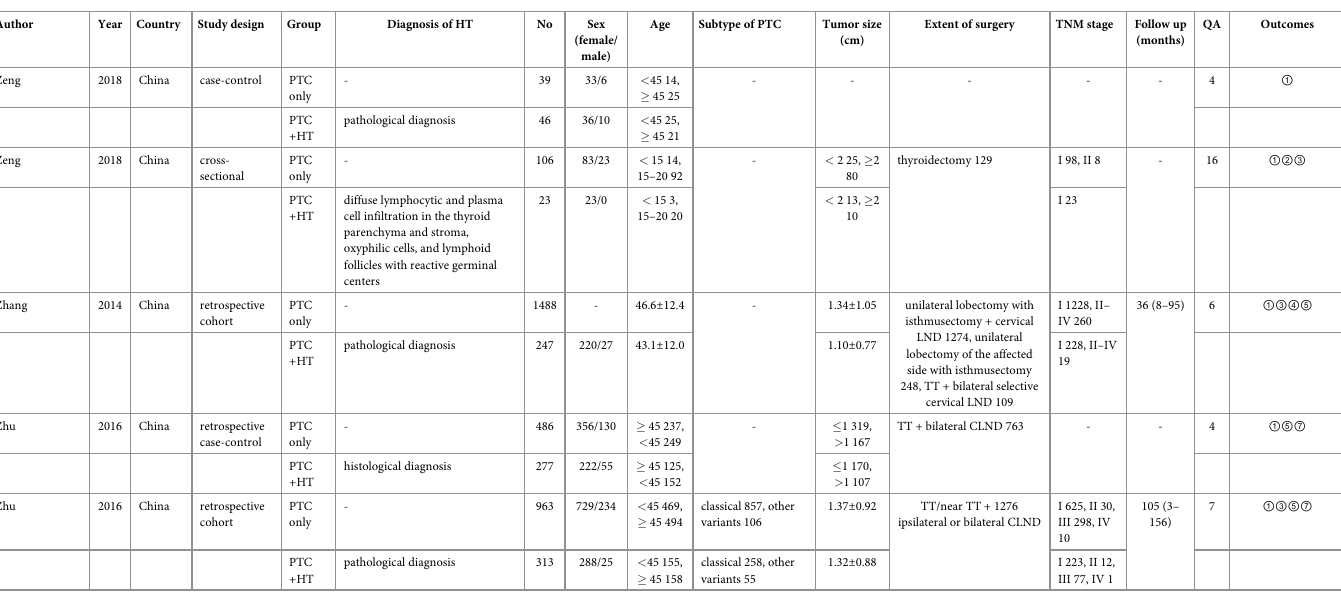
Invasion Vascular invasion. Totally 17 studies embodying 1837 patients probed into the vascular invasion. The result demonstrated that PTC patients with HT had a lower risk of vascular inva- sion than those without (OR: 0.718, 95%CI: 0.572–0.901, P = 0.004) (Table 2, Fig 6). Capsular invasion. Nine studies including 2273 patients assessed the capsular invasion. No difference was found between the HT and non-HT groups in capsular invasion (OR: 1.234, 95%CI: 0.829–1.835, P =